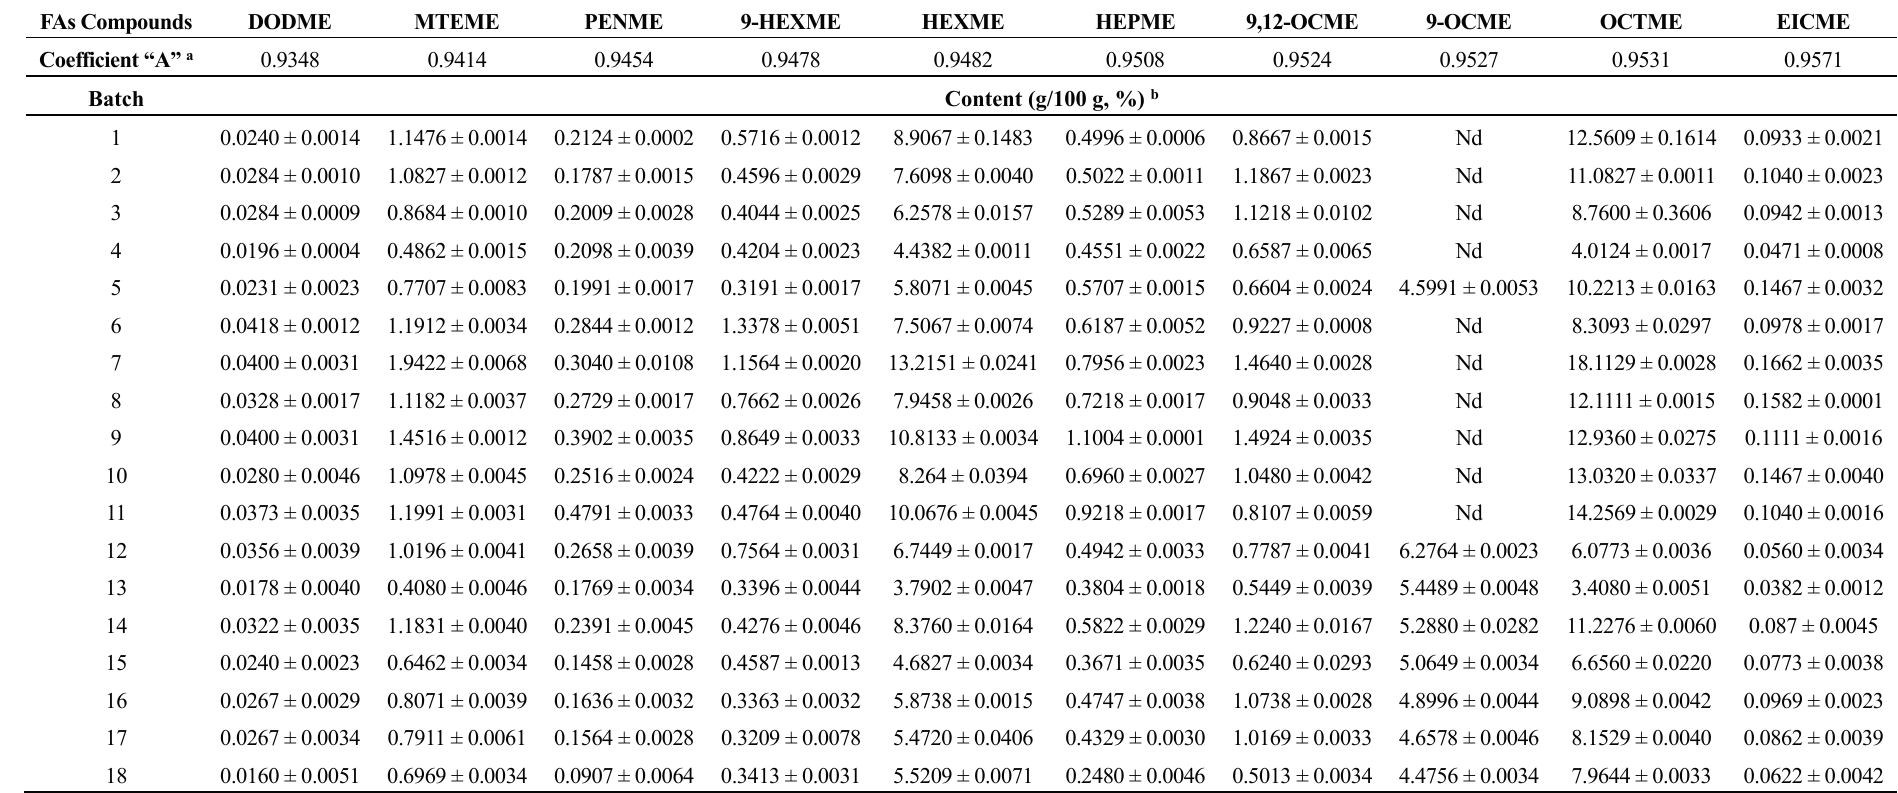
Table 3. Contents of ten FAs in 18 batches of Suet oil ( n =